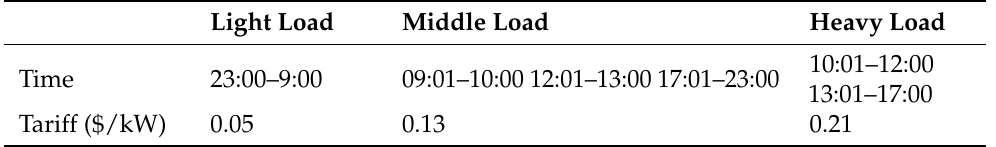
Table 6. Time of use (TOU) energy tariff.